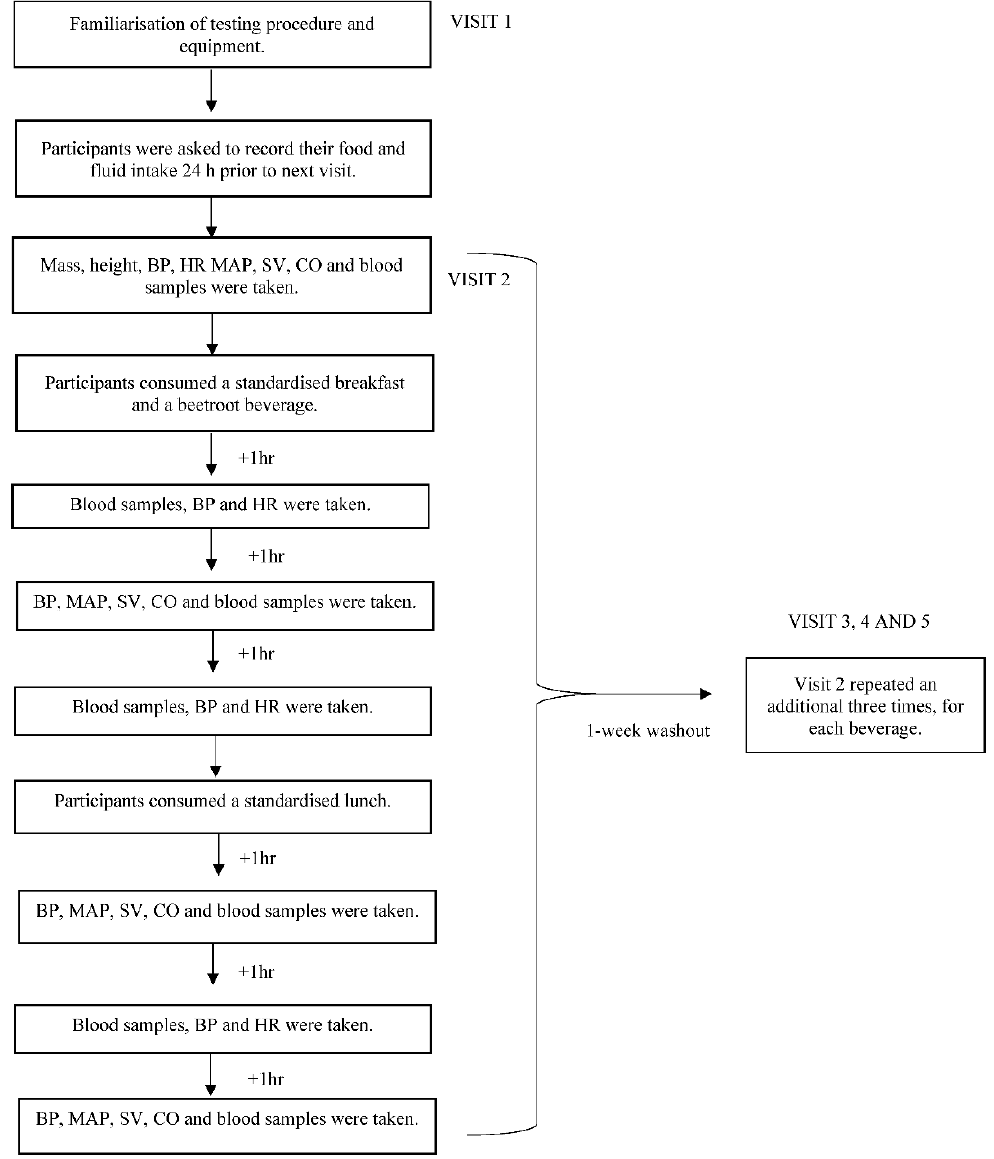
Figure 1. Protocol of the experimental trials. BP, blood pressure; HR, heart rate; SV, stroke volume; MAP, mean arterial pressure; CO, cardiac output.